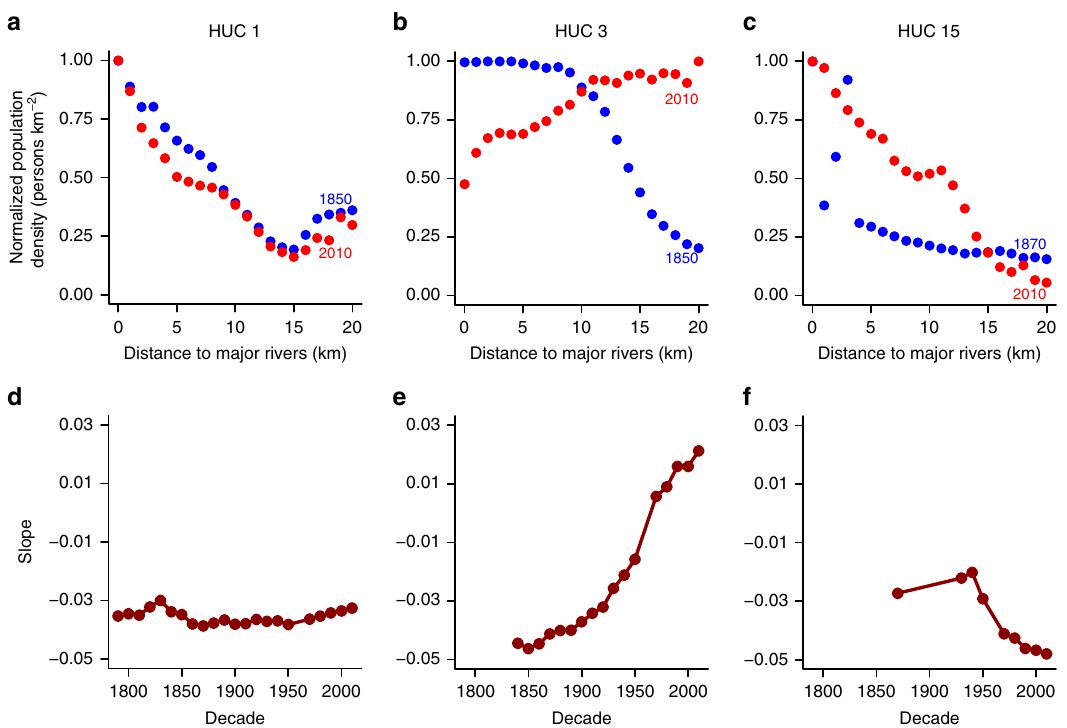
Fig. 4 Three major types of trajectories of human water coevolution. a HUC 1, 1850 – 2010, b HUC 3, 1850 – 2010, and c HUC 15, 1870 – 2010. d – f The dynamics of the slope of normalized population density (NPD) vs. distance to major rivers (DMR) for HUC 1, 3, and 15, 1790 – 2010. Only slopes with p < 0.05 during the settlement periods are shown. The data points for a – c are based on DMR classes while those for d – f are based on census